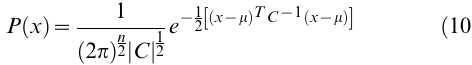
Figure S1 Measure of the total K-L divergence between data- based and synthetic models for 2, 5, and 8 ms, as a function of subspace dimensionality. Mean 6 SD across 10 6 validation is shown with error bars, which are on the order of the size of the markers for the points. Data presentation is as in Figure 9E, however here the K-L divergence has not been normalized (and so is in units of bits). Figure S2 Improvement of the synthetic model performance in LLR tests from the data from the 9 neurons shown in Figures 7D and 8B (black markers) by modification along their respective 3- dimensional iSTAC subspaces (cyan markers). Error bars represent 6 95% CIs on the